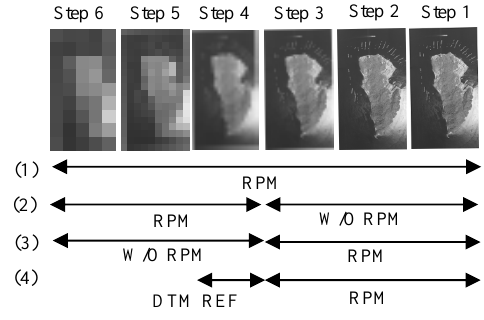
Figure 5 Restriction of the application of RPM in coarse-to-fine approach. Aerial photo by GSI Japan (2008)